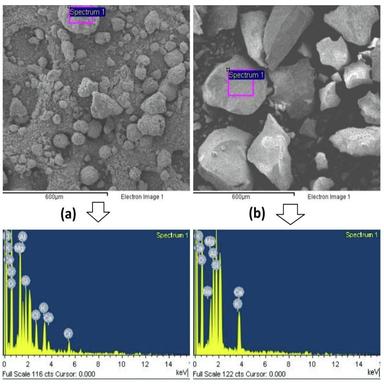
FESEM micrographs and EDX spectrum of (a) FCA (b) GGBFS.